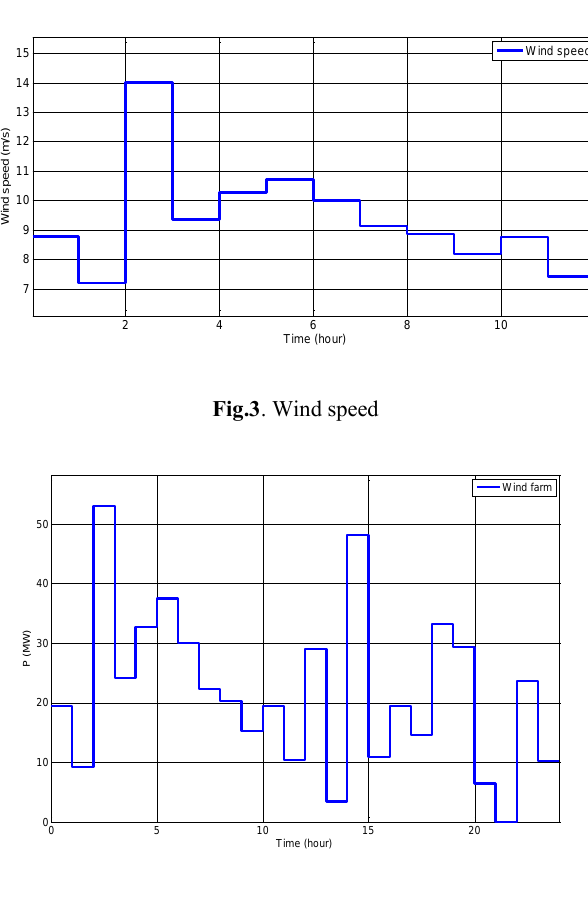
Fig. 4 . Active power of wind